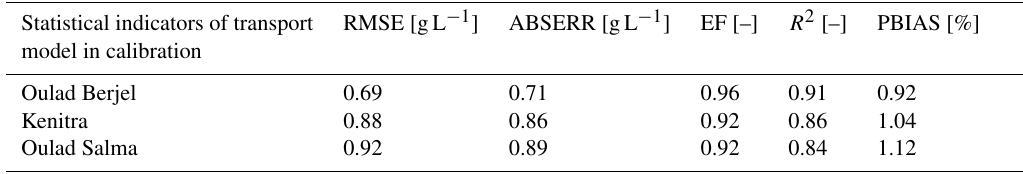
Table 9. Statistical indicators of transport model performance in calibration.